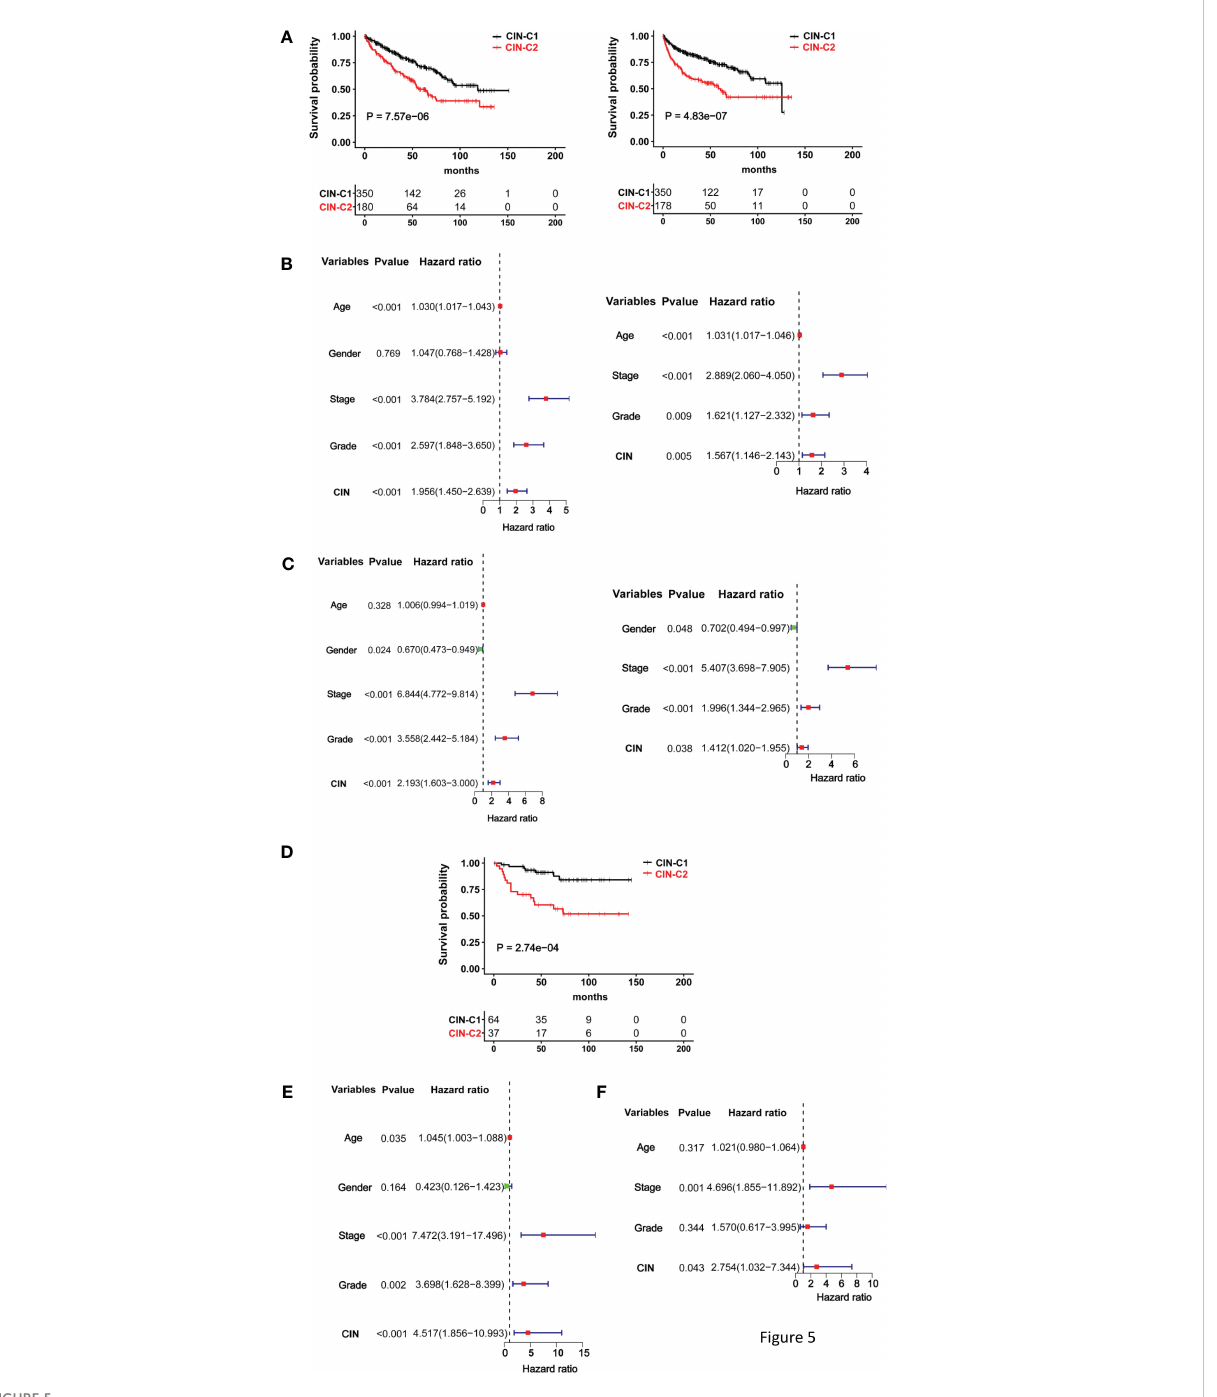
expression between responders and non-responders to Sunitinib. As expected, tumors from resistant patients expressed signi fi cantly higher levels of EZH2 than did those from responders ( P = 0.021 and 0.004, respectively) (Figure 8C).